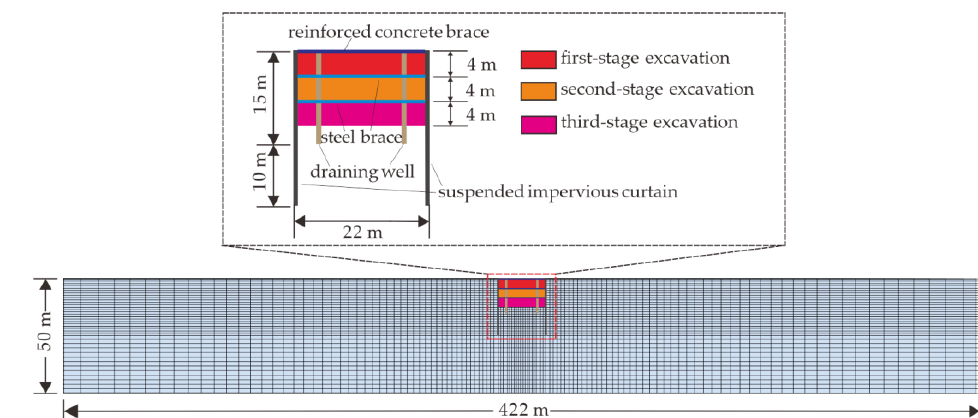
Figure 3. The excavation model adopted in the finite element analysis.